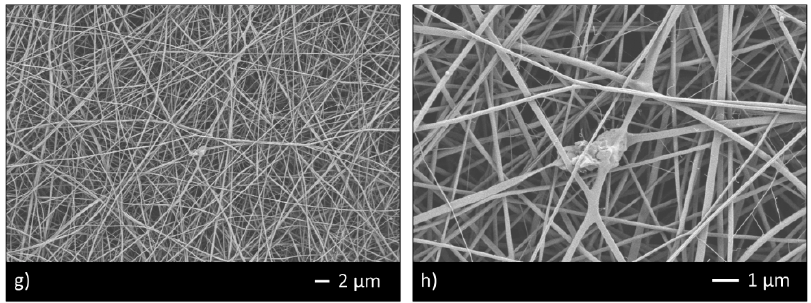
Figure 2. SEM analysis of CHIT_PEO ( a , b ); CHIT_PEO_45S5 ( c , d ); CHIT_PEO_BG10 ( e , f ) and CHIT_PEO_BGZn ( g , h ).